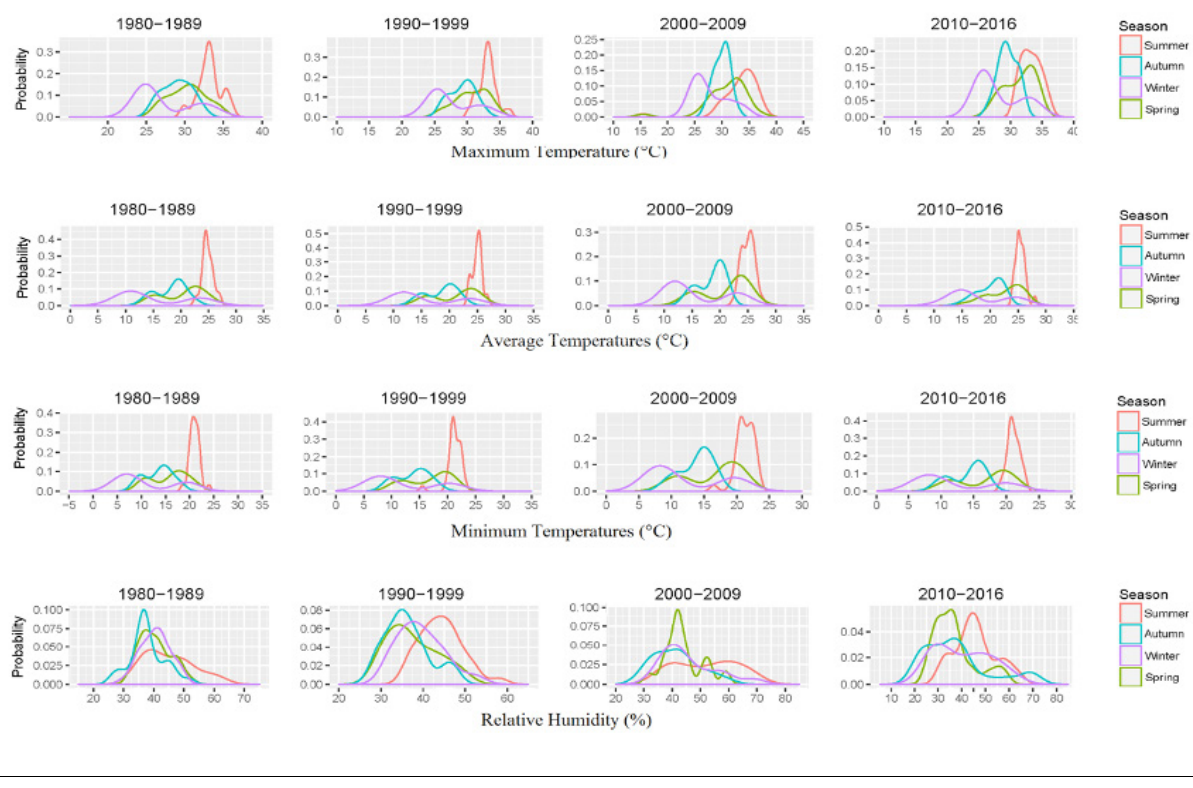
Figure 9: Decadal probability densities of seasonal relative humidity and air temperature (maximum, average and minimum) trends for northernmost Limpopo Province, 1980–2016. Probability density plots, which establish variability of relative humidity and air temperature, were calculated using R software package